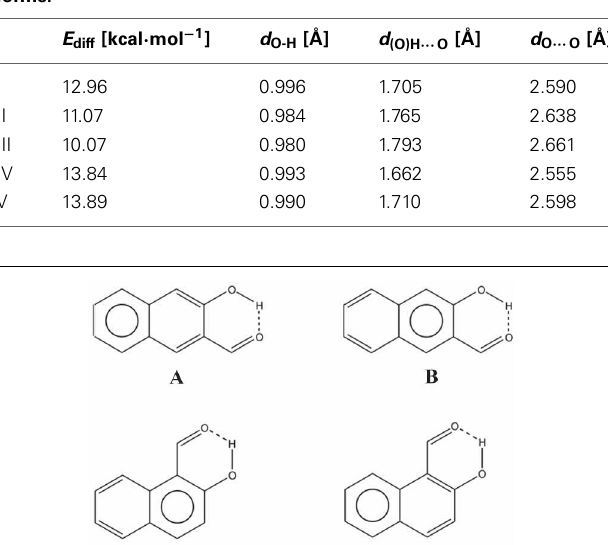
Table 1 | B3LYP/6-311+G ∗∗ selected geometrical parameters usually considered as indicators of hydrogen bond strength for the closed cis form and energy difference between the closed cis and the open cis forms.